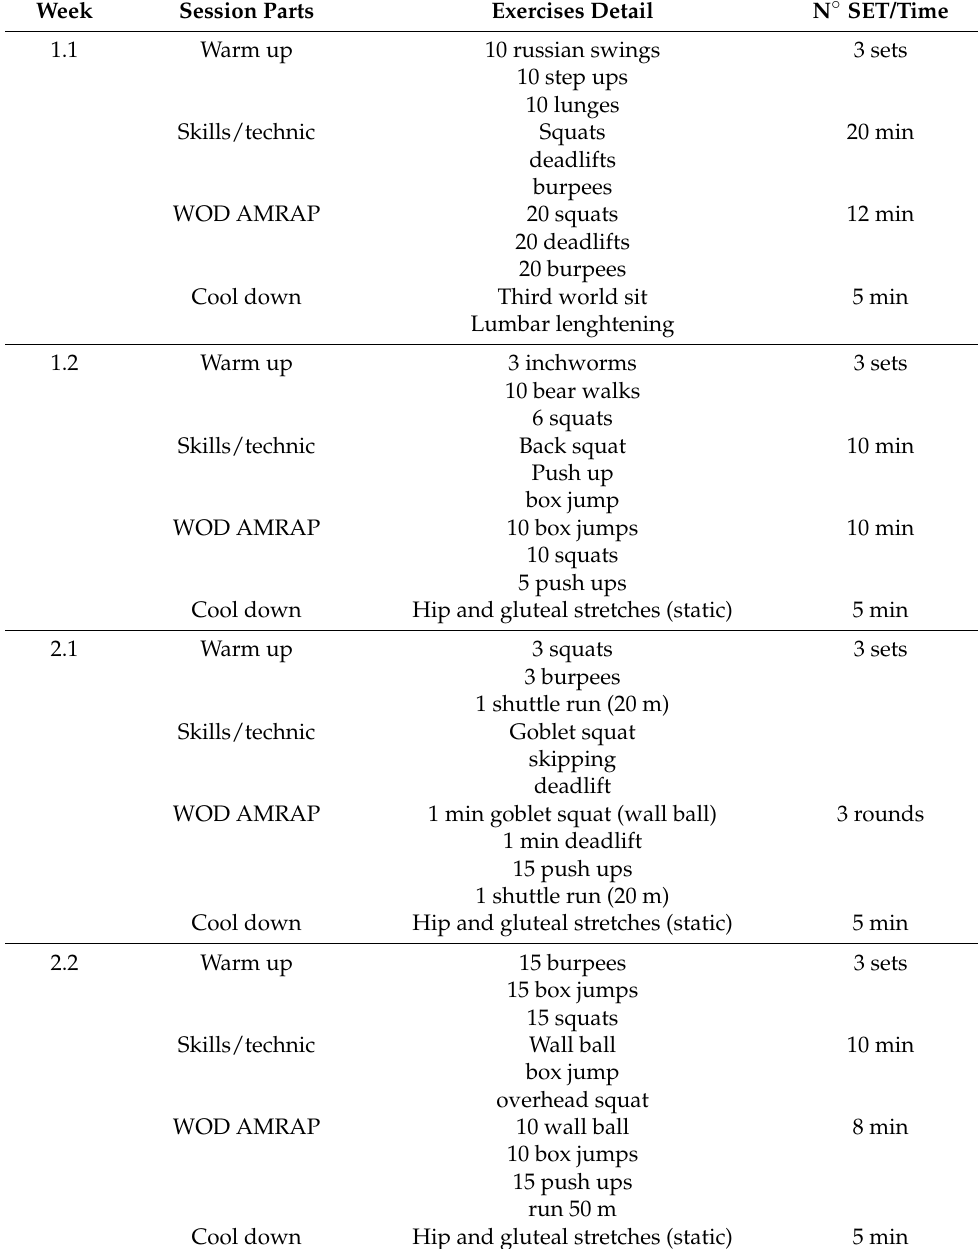
Table 2. Exercise CrossFit program